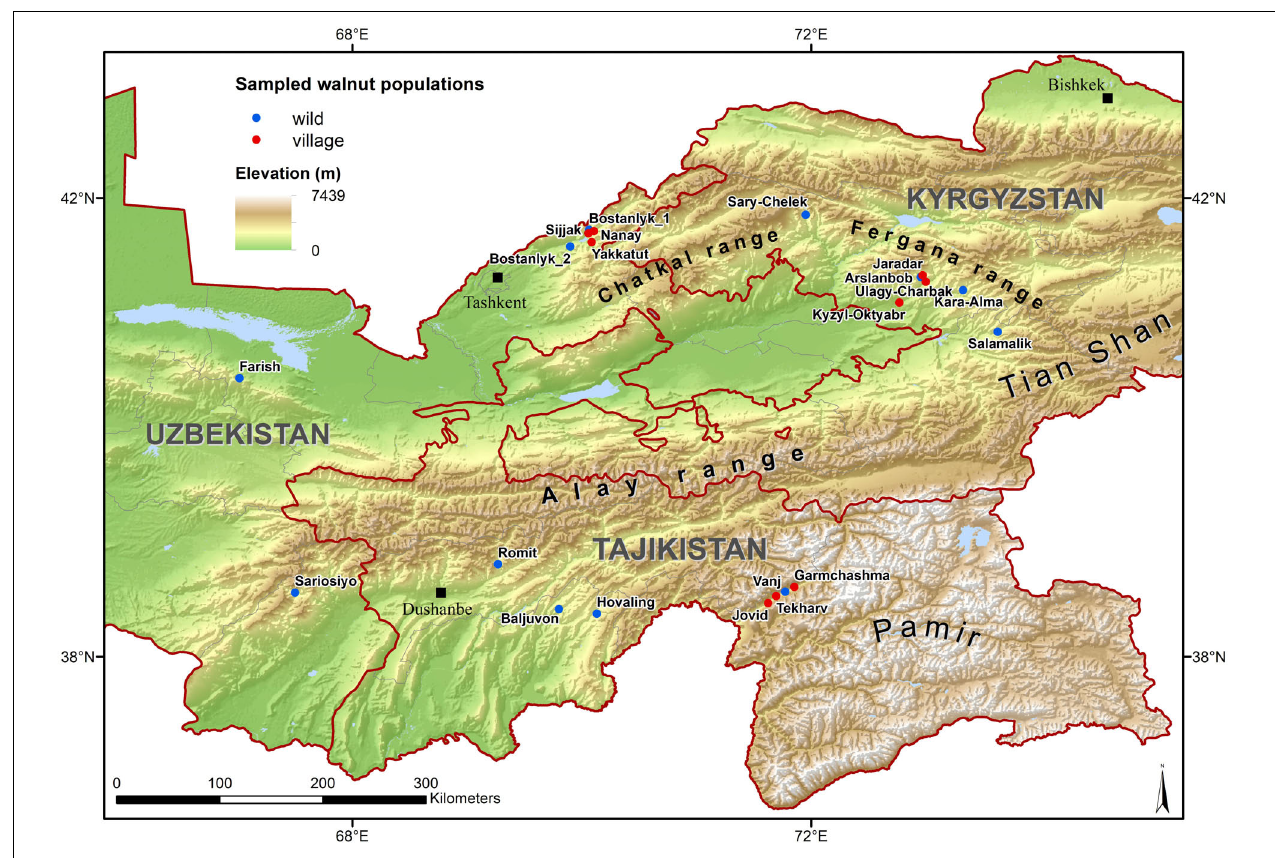
FIGURE 1 | Study area with 21 sampled wild and cultivated populations of Juglans regia